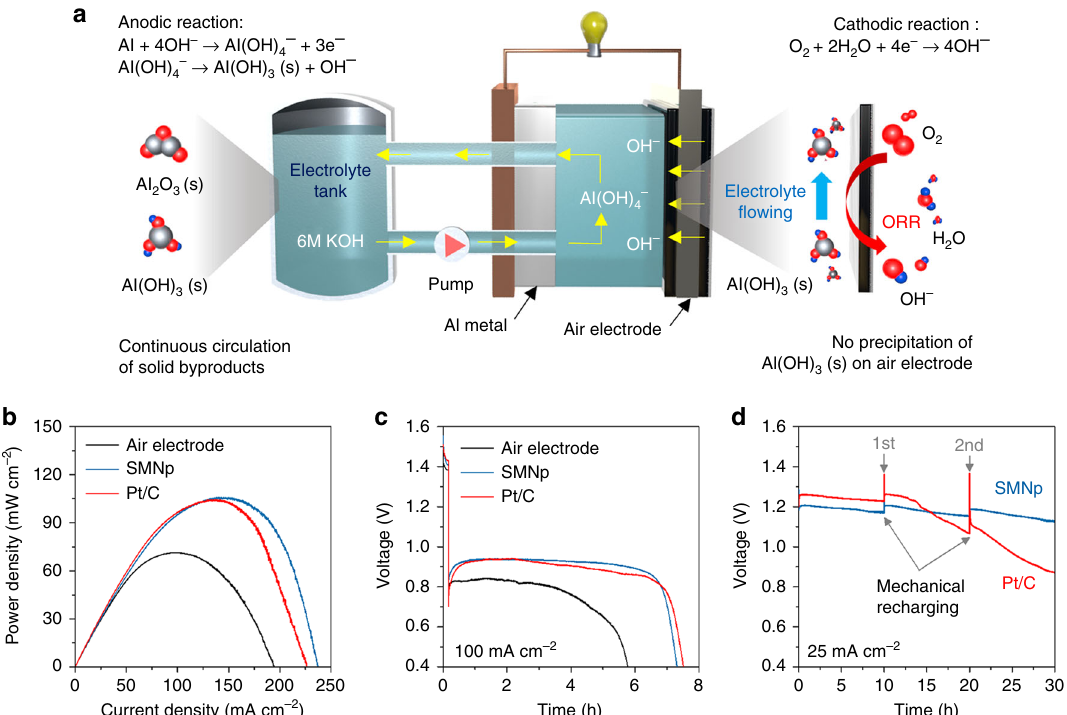
Fig. 4 Electrochemical performance of aluminum – air fl ow batteries. a Schematic of the aluminum – air fl ow battery (AAFB) system, which includes a single stack cell, one electrolyte tank, and circulation pump. ORR indicates oxygen reduction reaction. b Power density curves of fl ow cells using the pristine air electrode, silver manganate nanoplate (SMNp), and Pt/C with 6 M KOH electrolyte (scan rate of 0.1 mA s − 1 ). c Discharge curves using the pristine air electrode, SMNp, and Pt/C at 100 mA cm − 2 . d Mechanical charge and discharge tests using the SMNp and Pt/C at 25 mA cm − 2 , where the aluminum